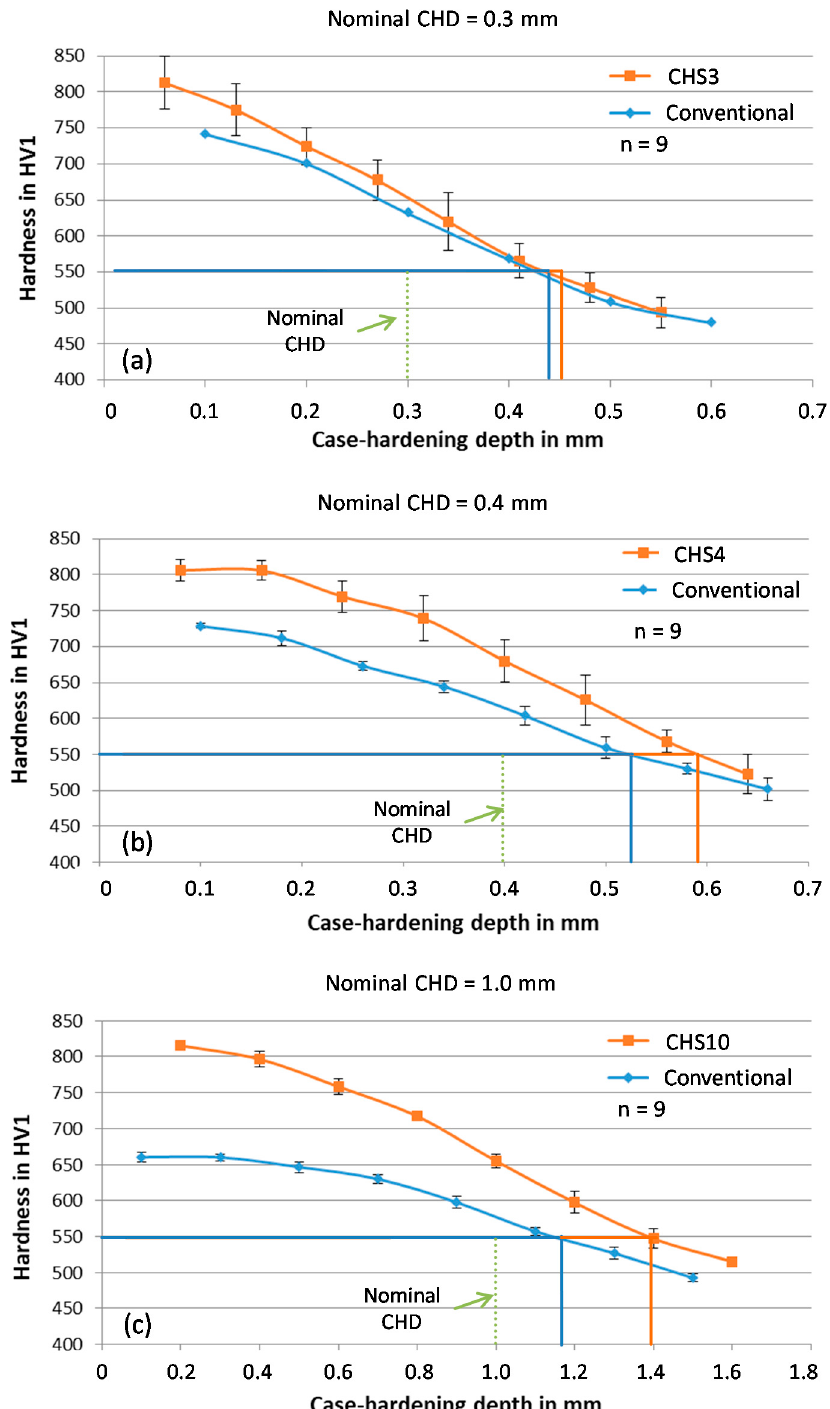
Figure 6. Comparison of CHD over hardness for conventionally and additively manufactured specimens (( a ) CHD = 0.3 mm; ( b ) CHD = 0.4 mm; ( c ) CHD = 1.0 mm), no heat treatment strategy.